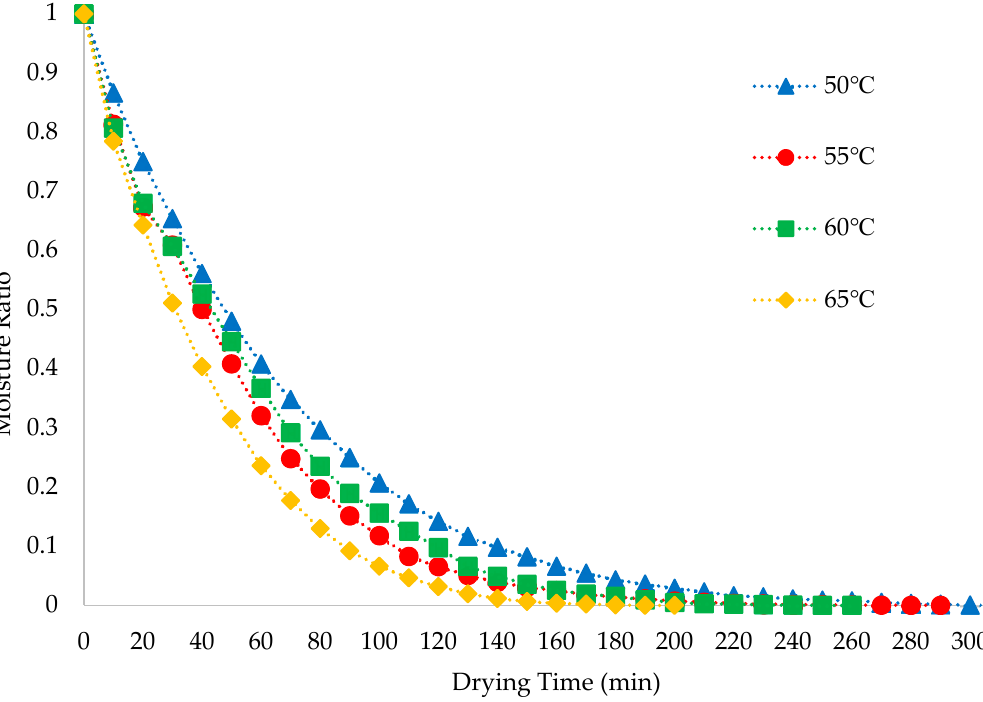
Figure 3. Drying curves of lemongrass slices at different temperature.